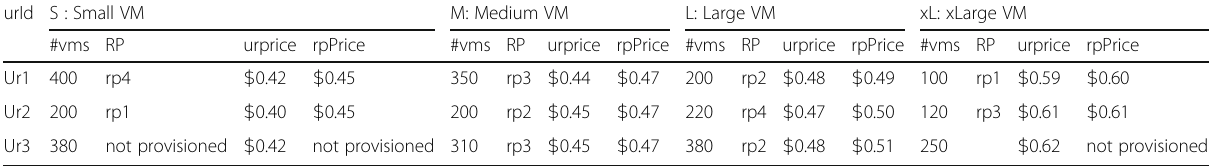
Table 4 A sample output of resource allocation done by individual cloud users urId S : Small VM